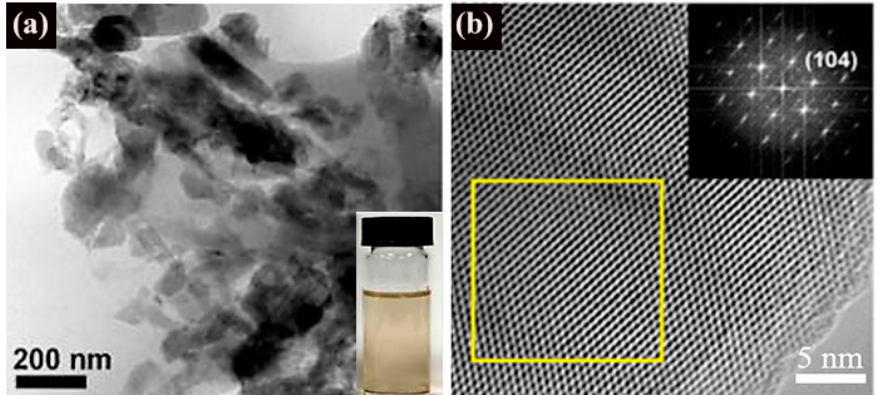
Figure 8. ( a ) Typical TEM images of the few-layer B sheets prepared by tip sonication. The inset is a photograph of B-sheet dispersions and sonication after 4 h. ( b ) Typical TEM image of the few-layer B sheets. The inset shows the corresponding FFT pattern [62]. Copyright 2018, American Chemical Society.